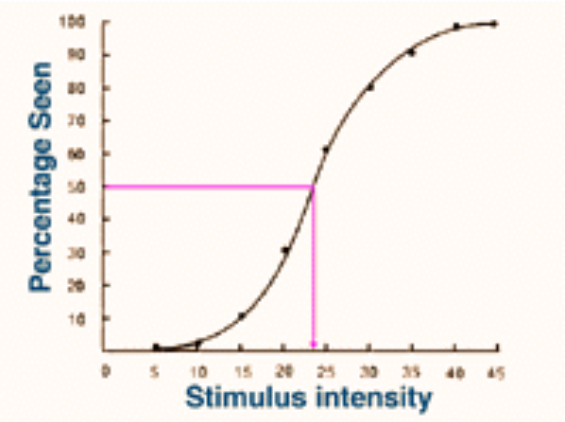
Figure 2 . An ogive curve or psychometric function where a criterion dependent method was applied is illustrated here - only yes or no responses to the presence of stimuli of variable intensity were required. The threshold value is defined where 50% of the stimuli are detected, and in this figure the stimulus intensity threshold is 23.5 (Reproduced with permission from Webvision) 5 .